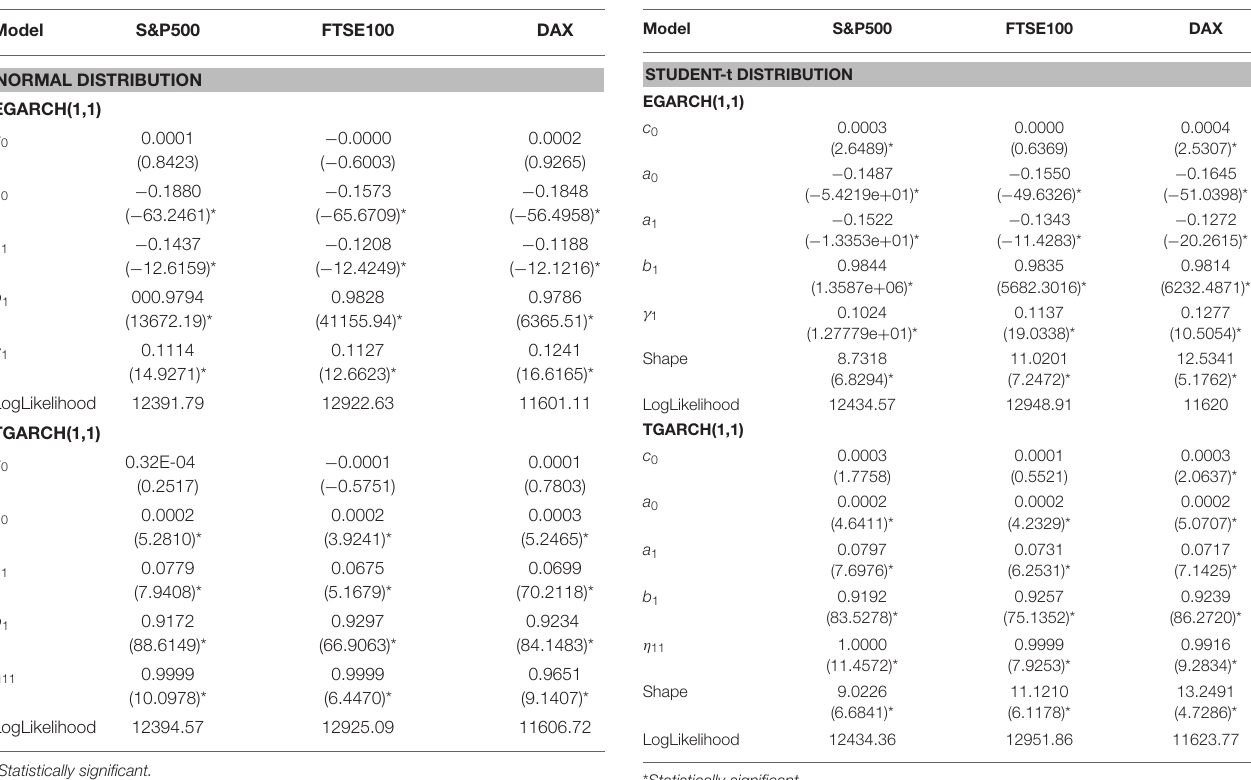
TABLE 6 | Parameter estimates of EGARCH and TGARCH models for three equity indices using the entire data set and assuming Student-t distribution for the residuals, t-statistics are presented in